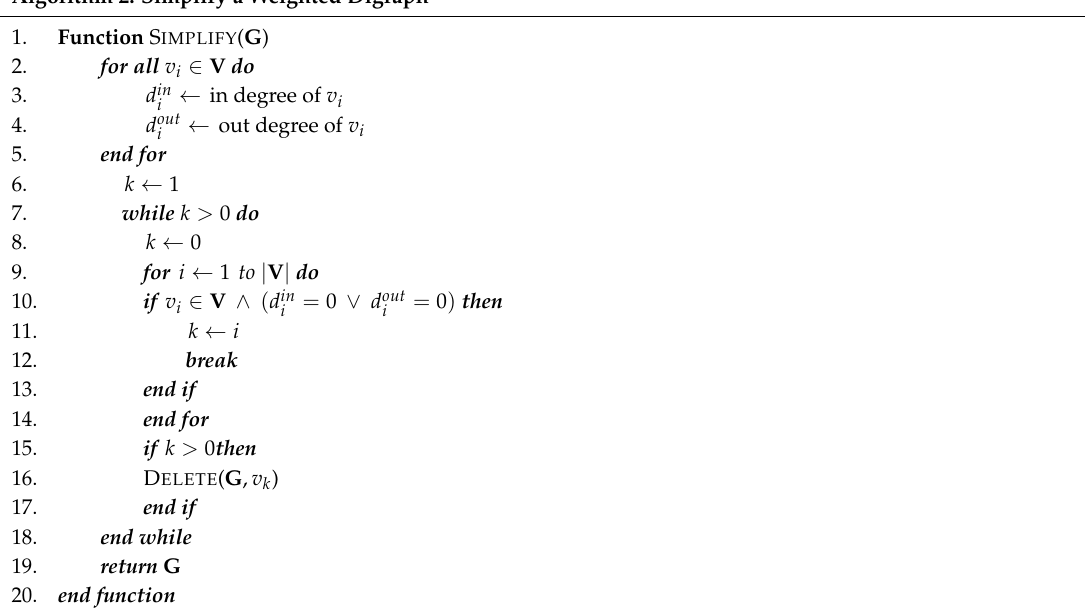
Algorithm 2. Simplify a Weighted